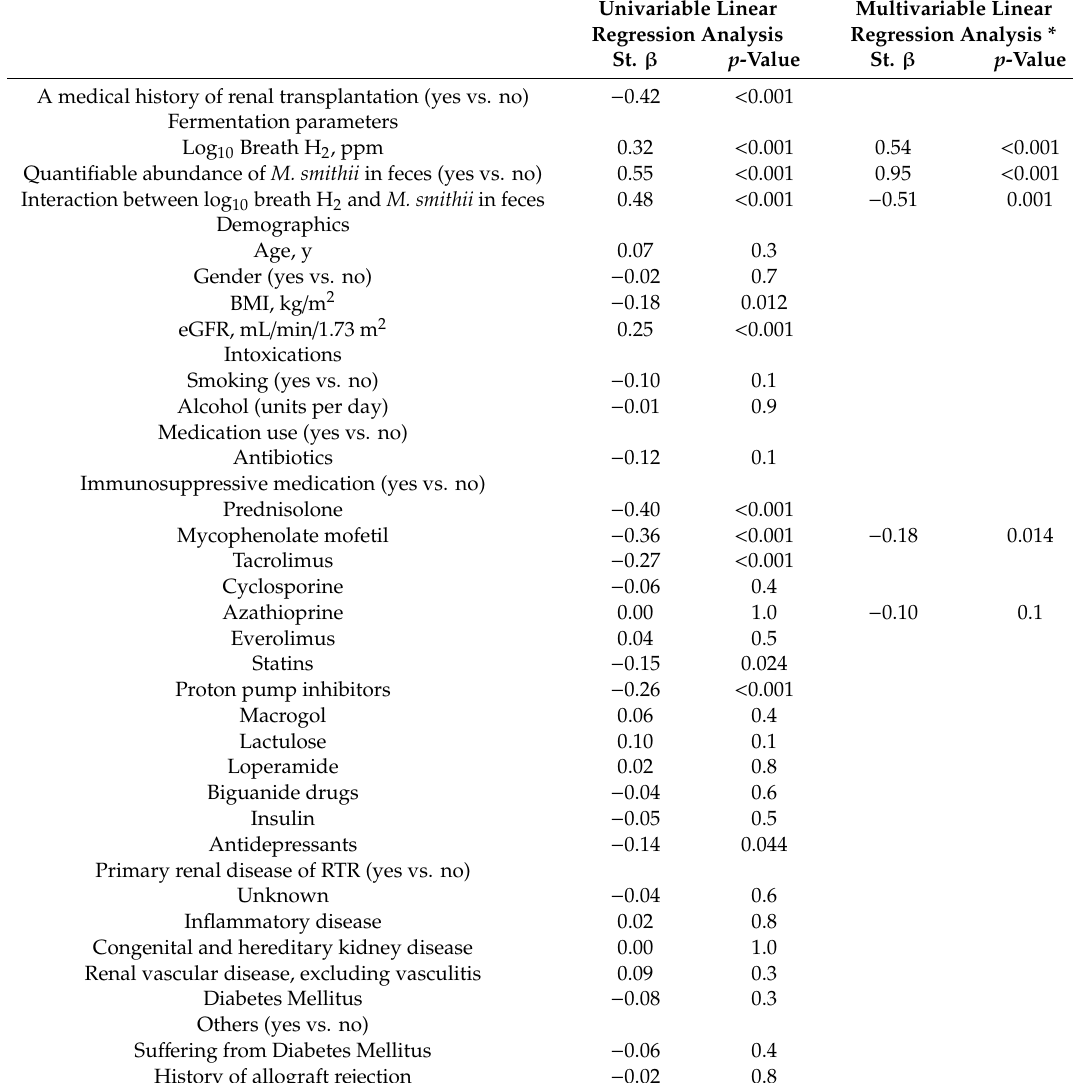
Table 2. Linear regression analysis of log 10 breath CH 4 concentration.